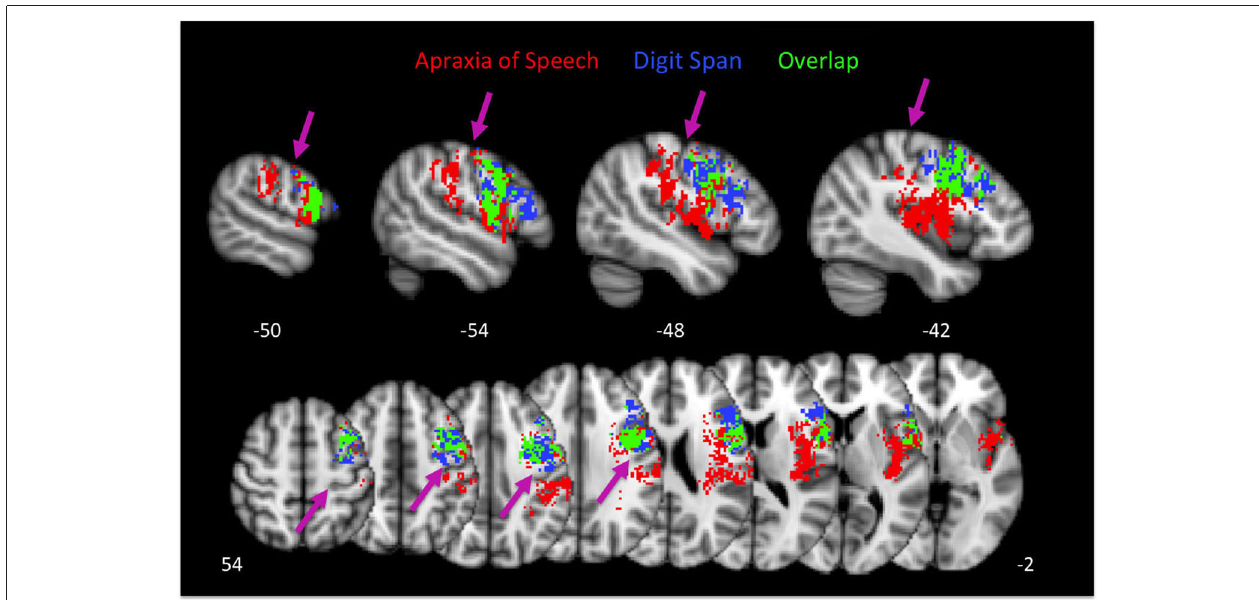
FIGURE 4 | Group maps showing the relation between voxels significantly related to apraxia of speech and impaired digit span performance . Arrows indicate the central